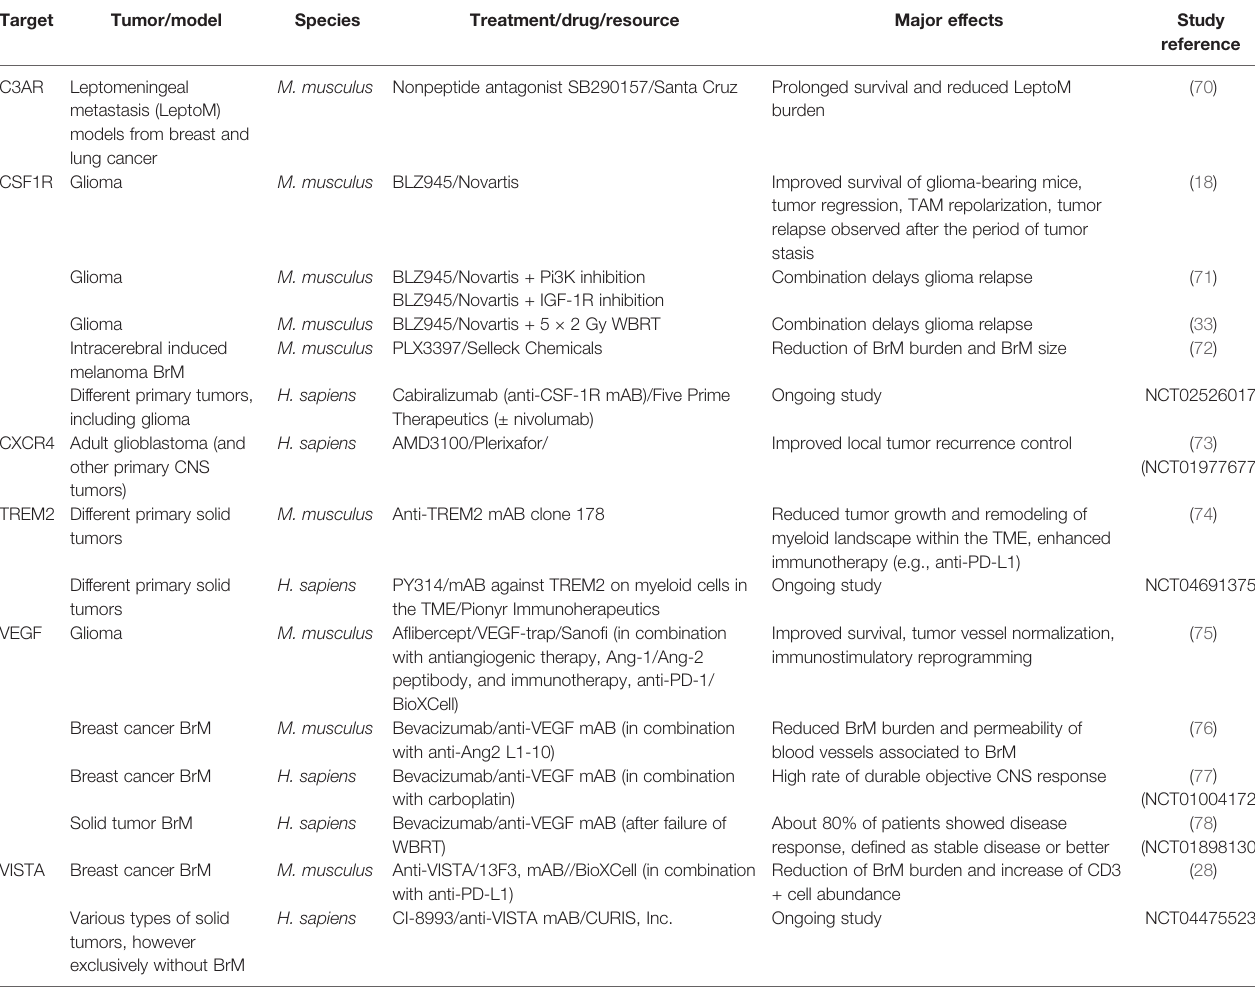
TABLE 3 | Examples of preclinical and clinical studies targeting certain TAM-related receptors/factors as mono- or combination therapies in various types of extra- and intracranial